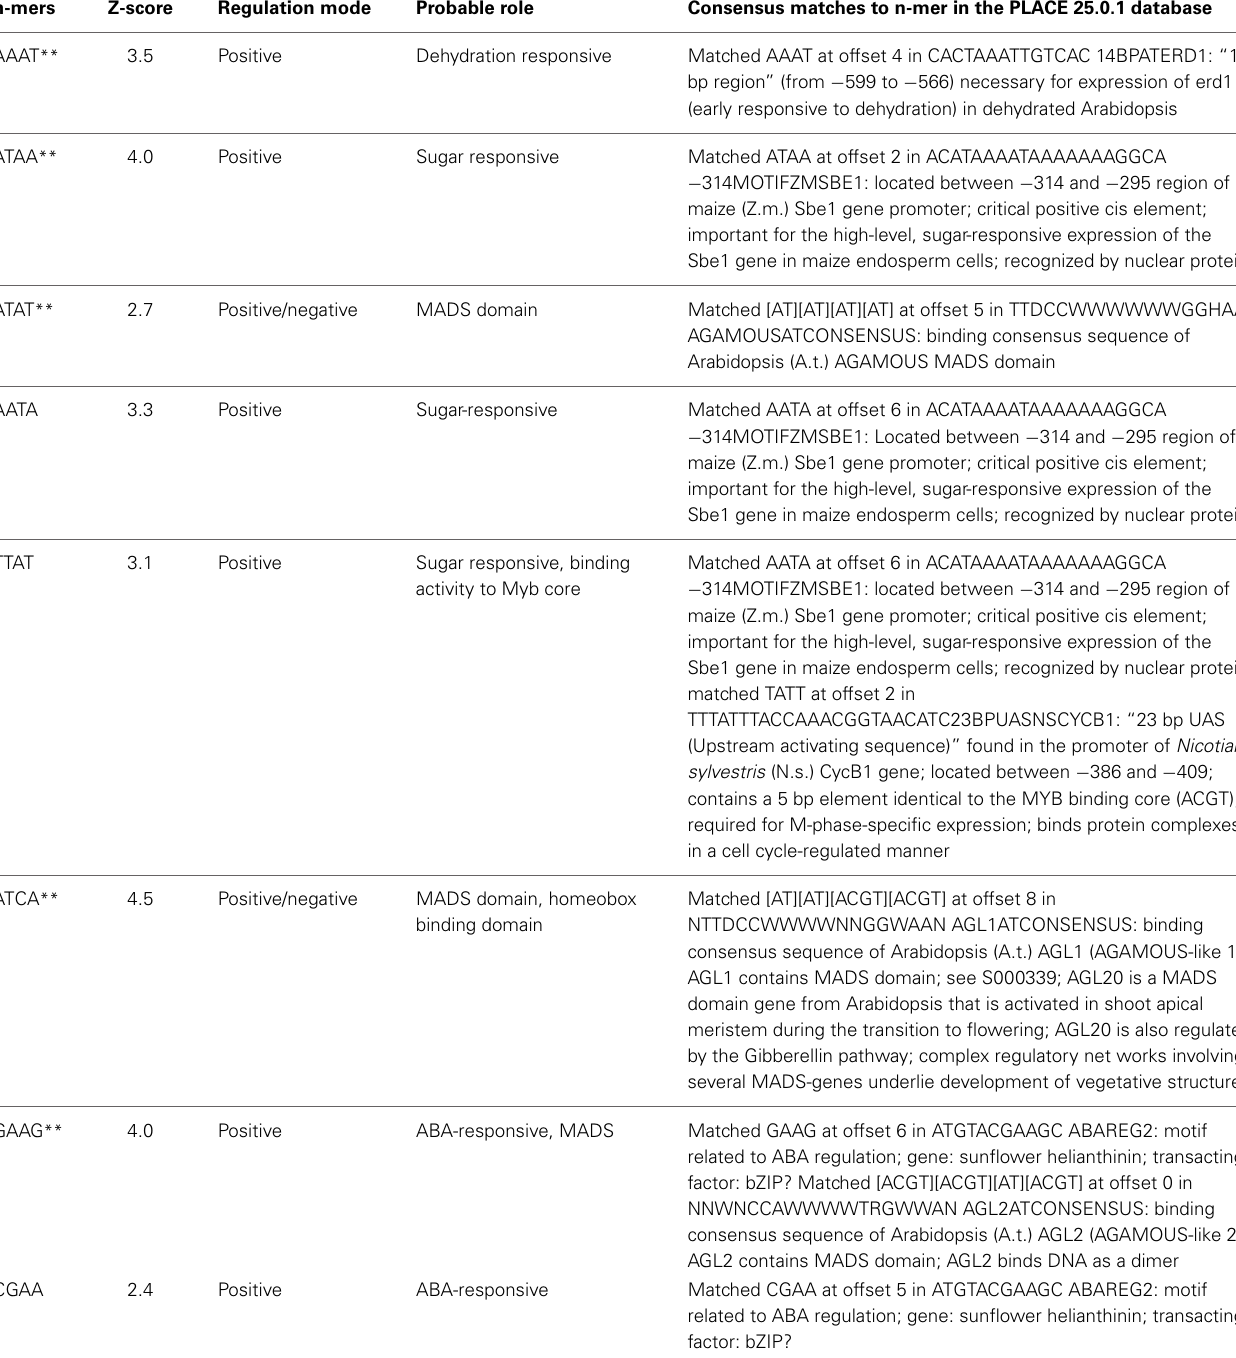
An html table for all n-mers is presented in Supplementary Table 1. ** denotes overrepresentation.